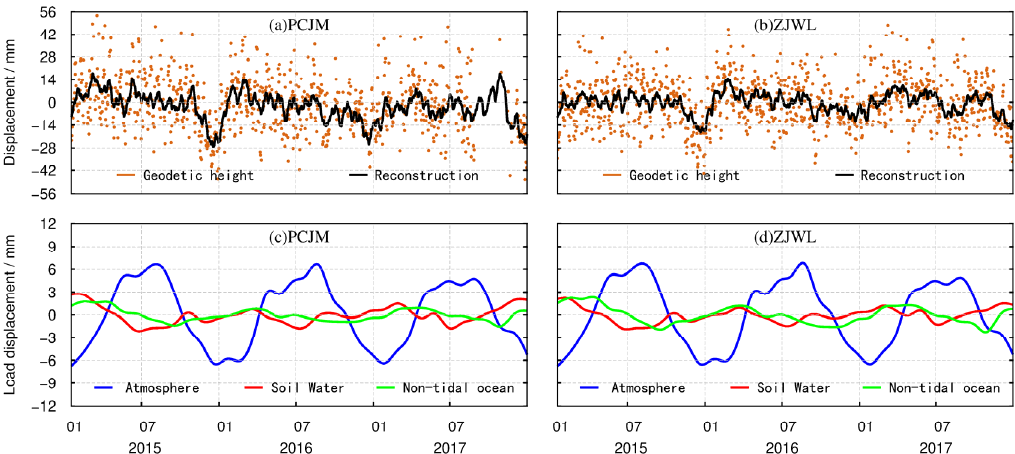
Figure 3. ( a ) The processed geodetic height at PCJM site; ( b ) The processed geodetic height at ZJWL site; ( c ) Crustal vertical deformation at PCJM site caused by environmental load; ( d ) Crustal vertical deformation at ZJWL site.